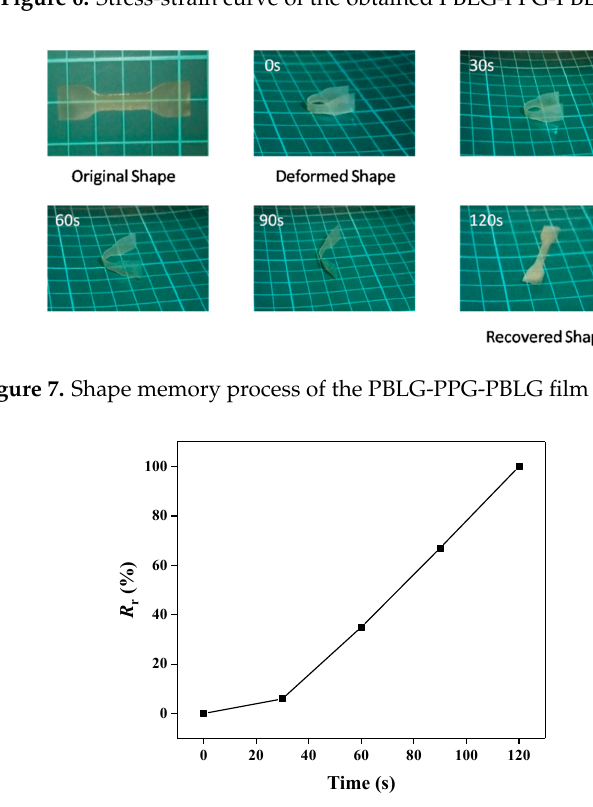
r ) versus recovery time. Appl. Sci. 2017 , 7 , 1258